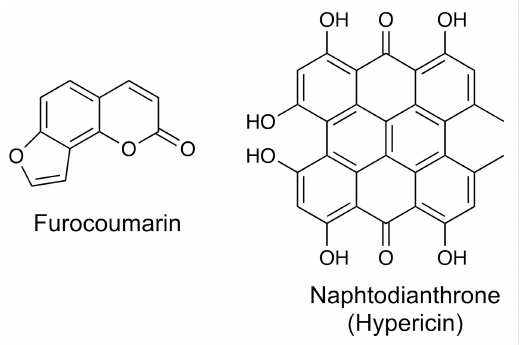
Figure 9. The chemical structures for hypericin (a naphthodianthrone) and